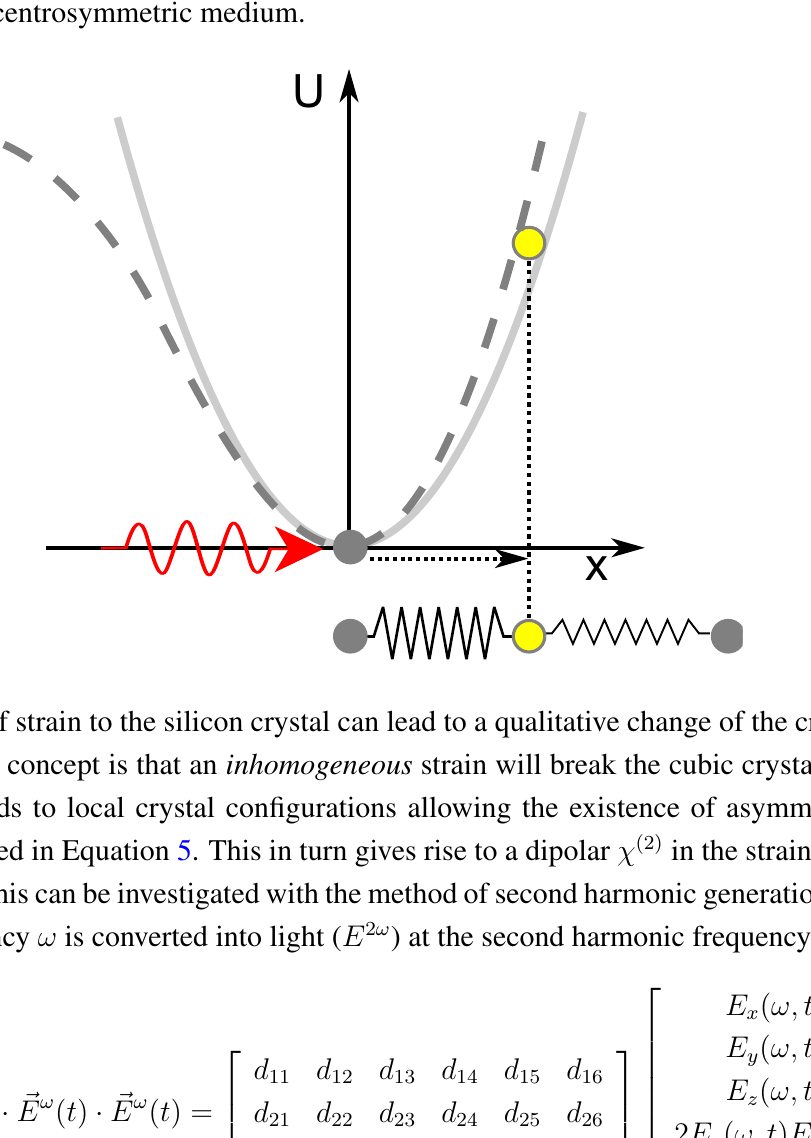
Figure 6. The excitation of an electron (yellow) by a photon (red) can be illustrated by an oscillation in a harmonic potential (solid line). In the case of nonlinear excitation neighboring atoms have to be taken into account as well, leading to asymmetric potentials (dashed) in the case of a non-centrosymmetric